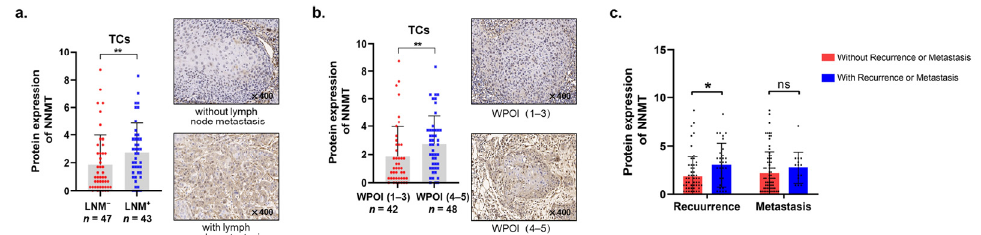
Figure 3. Correlation between the expression of NNMT and different clinical characteristics. ( a , b ) NNMT with different lymph node metastasis and WPOI in TCs. ( c ) Correlation between NNMT expression and the recurrence and metastasis status in TCs. * and ** represent differences that were considered statistically significant with p < 0.05 and p < 0.01, respectively; and ns represents no sta- tistical differences.